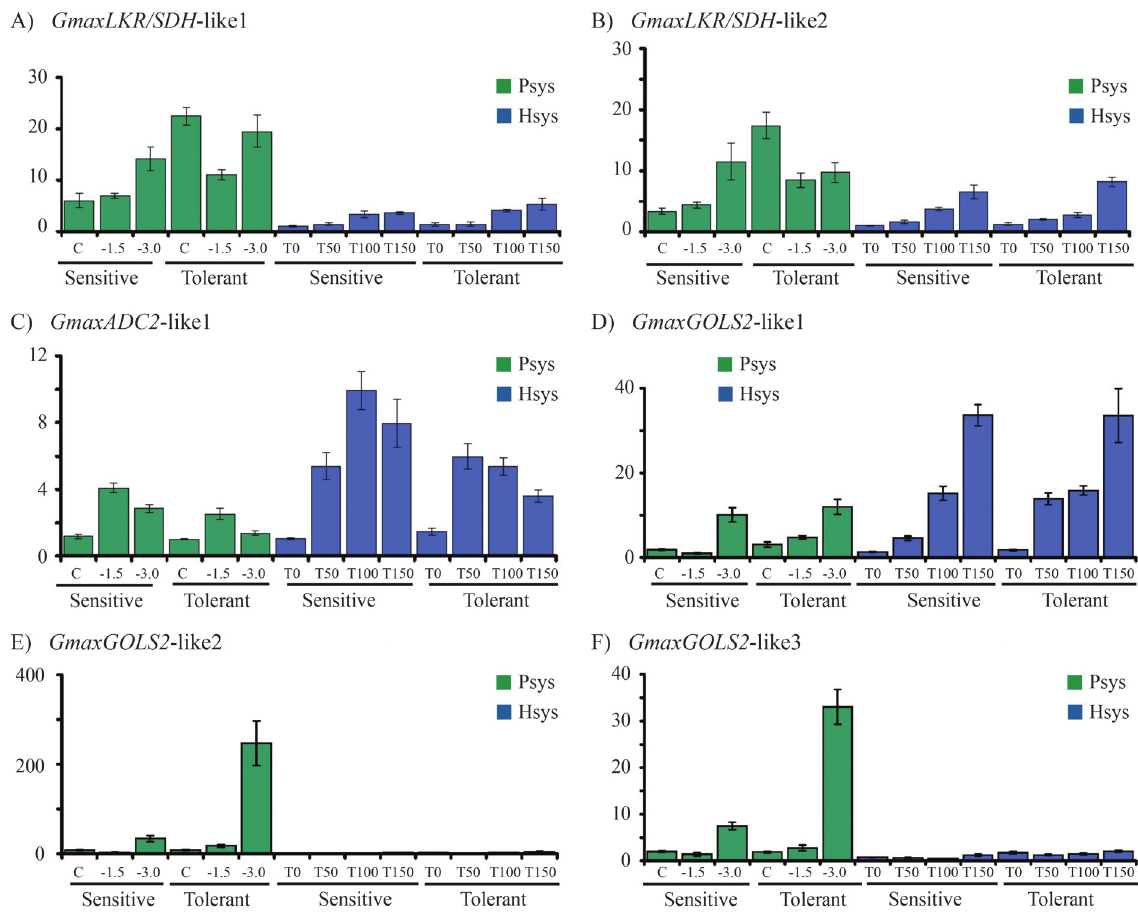
Figure 5 - Expression profile analyses of drought stress-related genes in pot-based (PSys) and hydroponic (HSys) cultivation conditions. A) GmaxLKR/SDH -like1, B) GmaxLKR/SDH- like2, C) GmaxADC2- like1, D) GmaxGOLS2 -like1, E) GmaxGOLS2 -like2 and F) GmaxGOLS2 -like3. The PSysconditionisrepresentedbygreensolidbarsandHSysbybluesolidgraybars.Thesensitive(BR16)andtolerant(Embrapa48)cultivarsareindicated at the bottom of the bars. Relative expression levels of these genes are represented on the Y-axis, relation to the reference genes ACT and FBOX in both cultivars and systems. The C, -1.5 and -3.0 represent control and the water potentials of soybean plants ( (cid:3) w) measured after the second day of the inter- ruptionofwatering.Sevendaysaftertheinterruptionofwateringthe (cid:3) wwas-1.5 (cid:2) 0.2MPa(moderatestresslevel)andaftertendays-3.0 (cid:2) 0.2MPa(se- verestresslevel).TheT0(control),T50(50min),T100(100min)andT150(150min)indicatethedifferenttimesunderdroughtstresswhichthesoybean seedlings were submitted after removed of the hydroponic